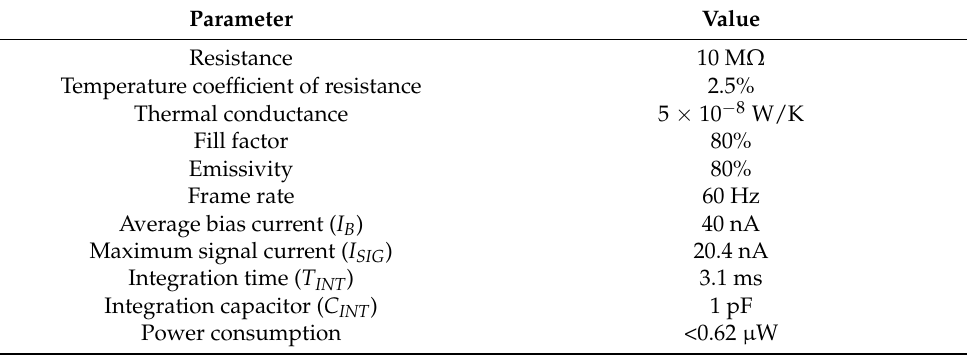
Table 1. Design parameters of the microbolometer and readout